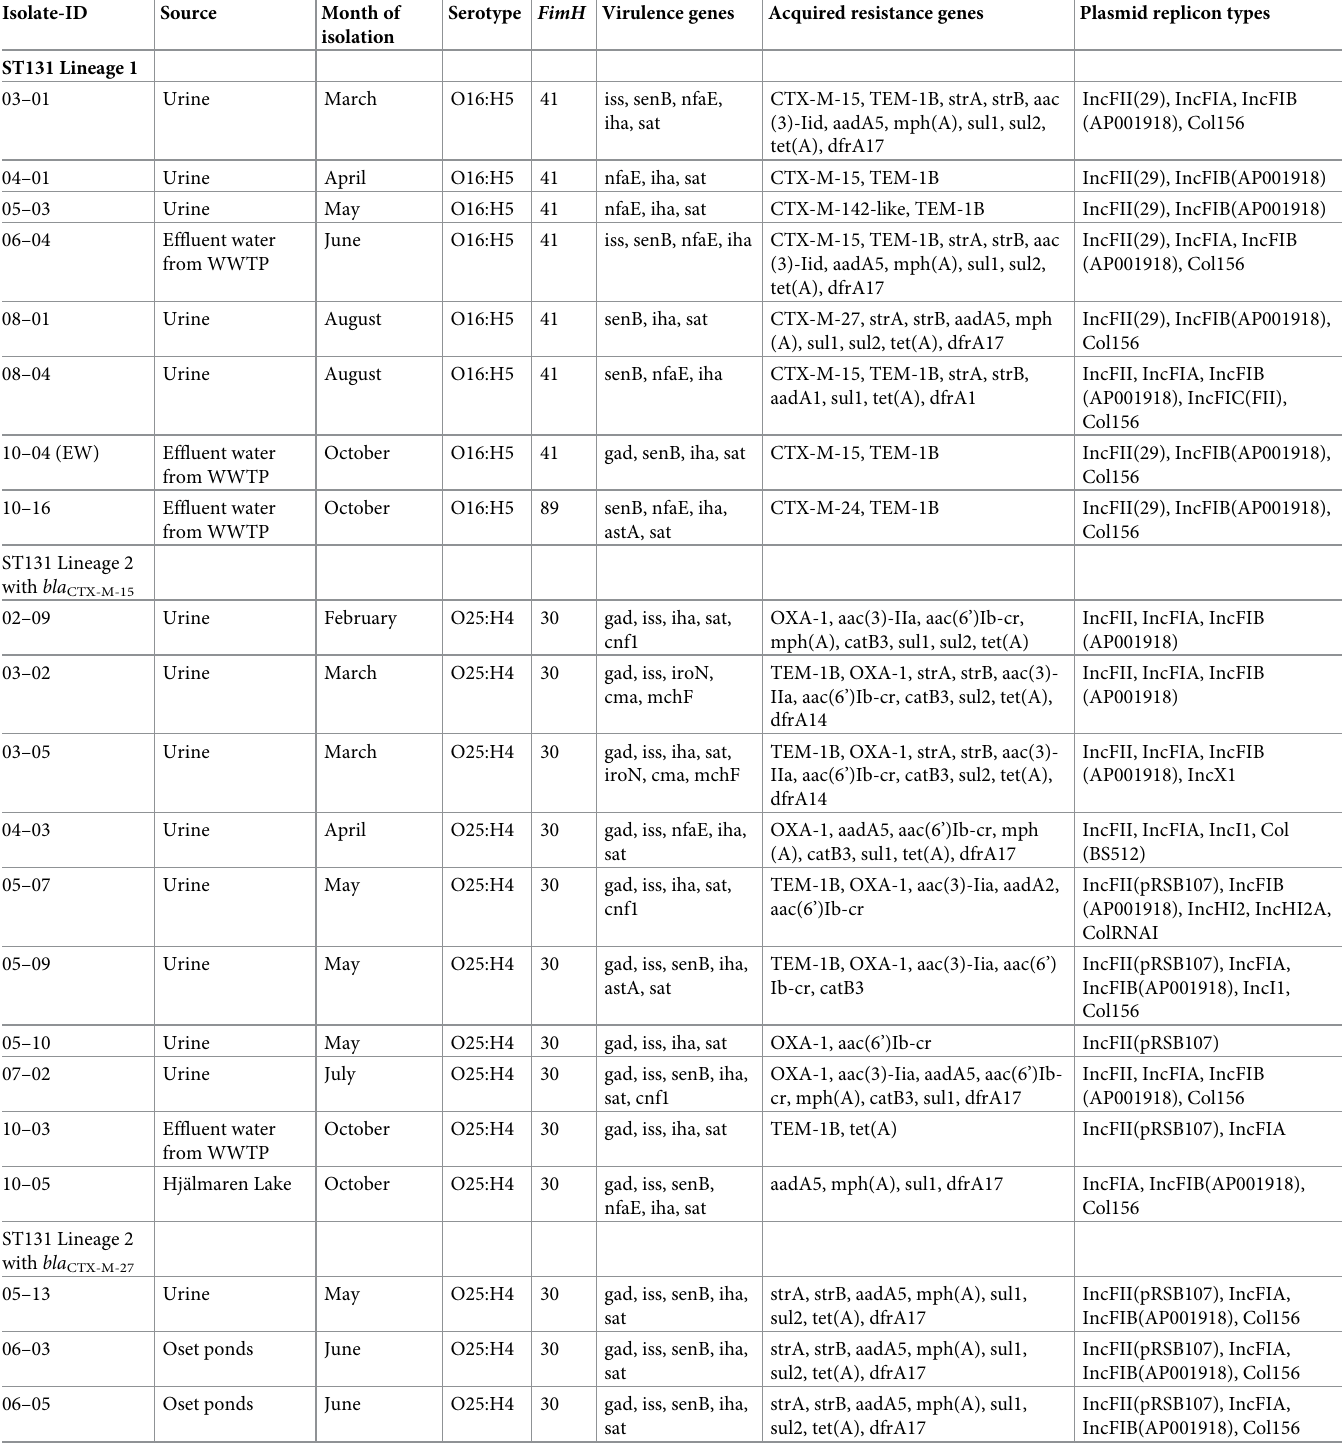
Table 2. Comparison of ST131